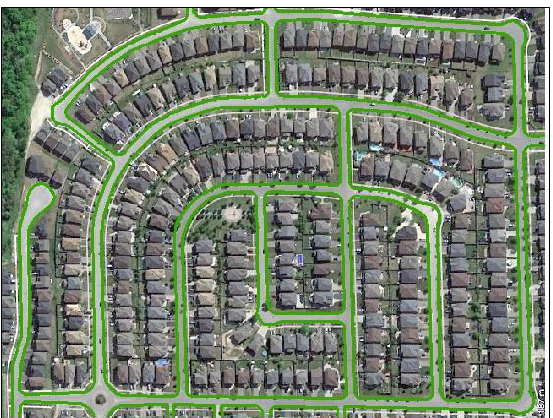
Figure 7. Ground truth of study area The approach described in the previous section is applied to the image. Result of road segment grouping is depicted in Figure